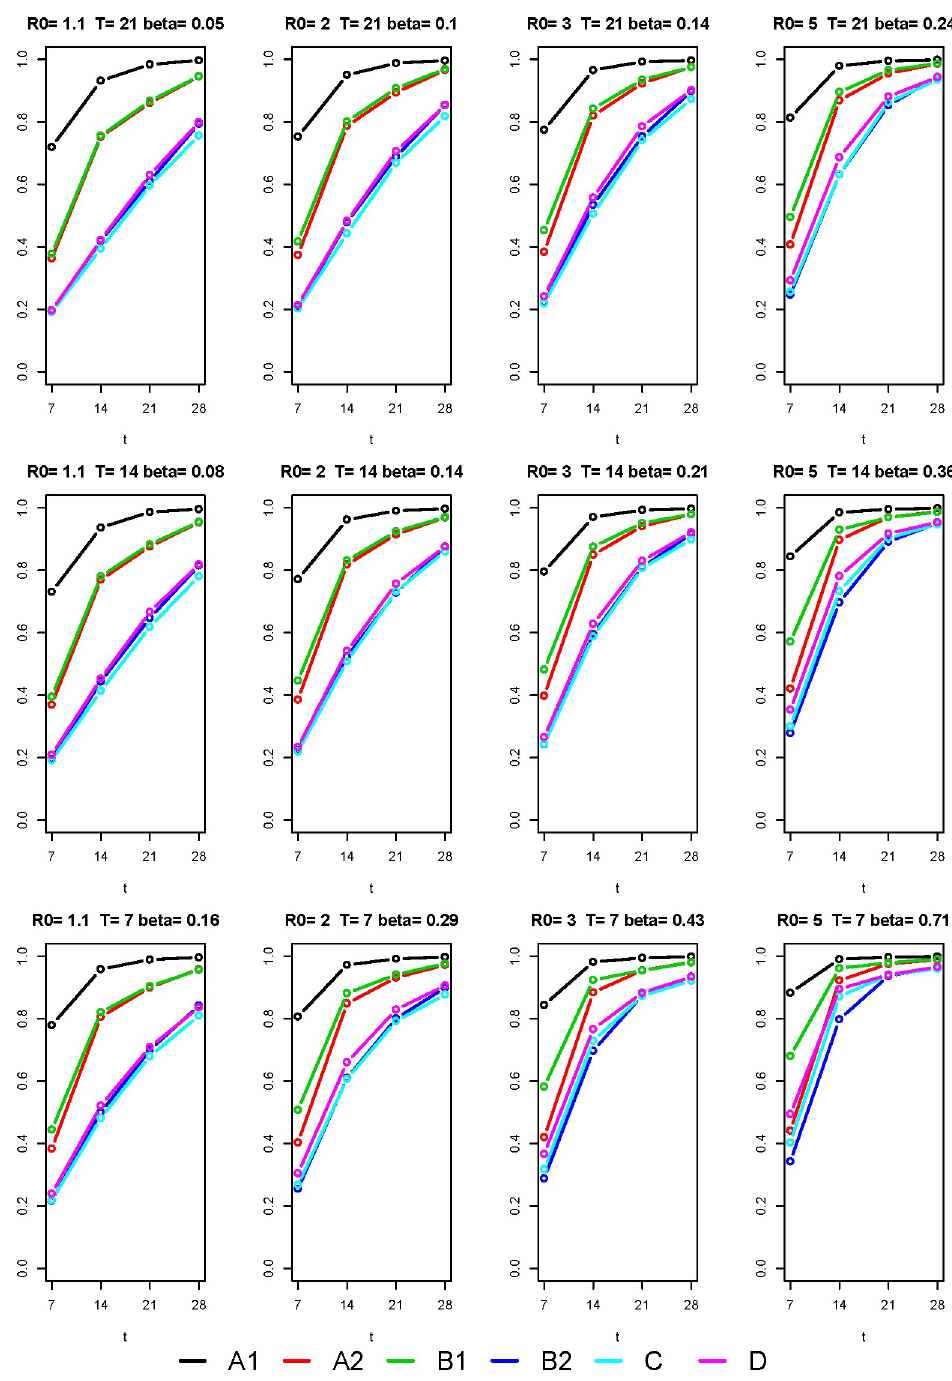
Fig 2. Probability of detecting the infection within t days from the beginning of the epidemic in the class. Comparison of the performance of the six screening plans (A1, A2, B1, B2, C, D), under different epidemic scenarios, assuming that individual tests have sensitivity 0.7 and maximum